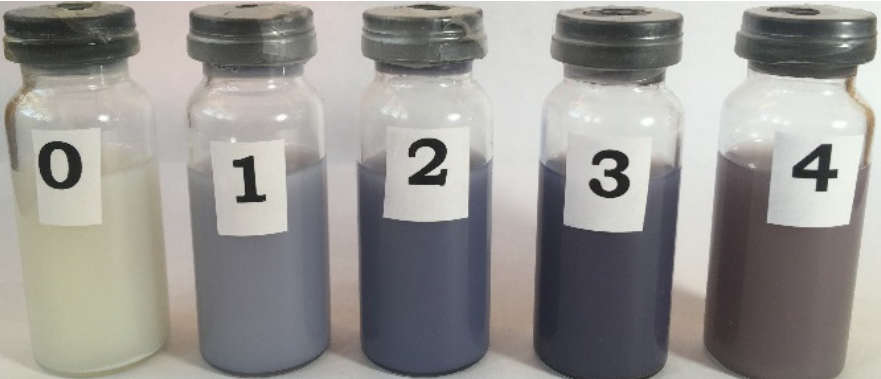
Figure 4. Samples of silver chloride sol. The photo was taken after three days of storage under different conditions. The concentration and storage conditions are shown in the second column of Table 1.